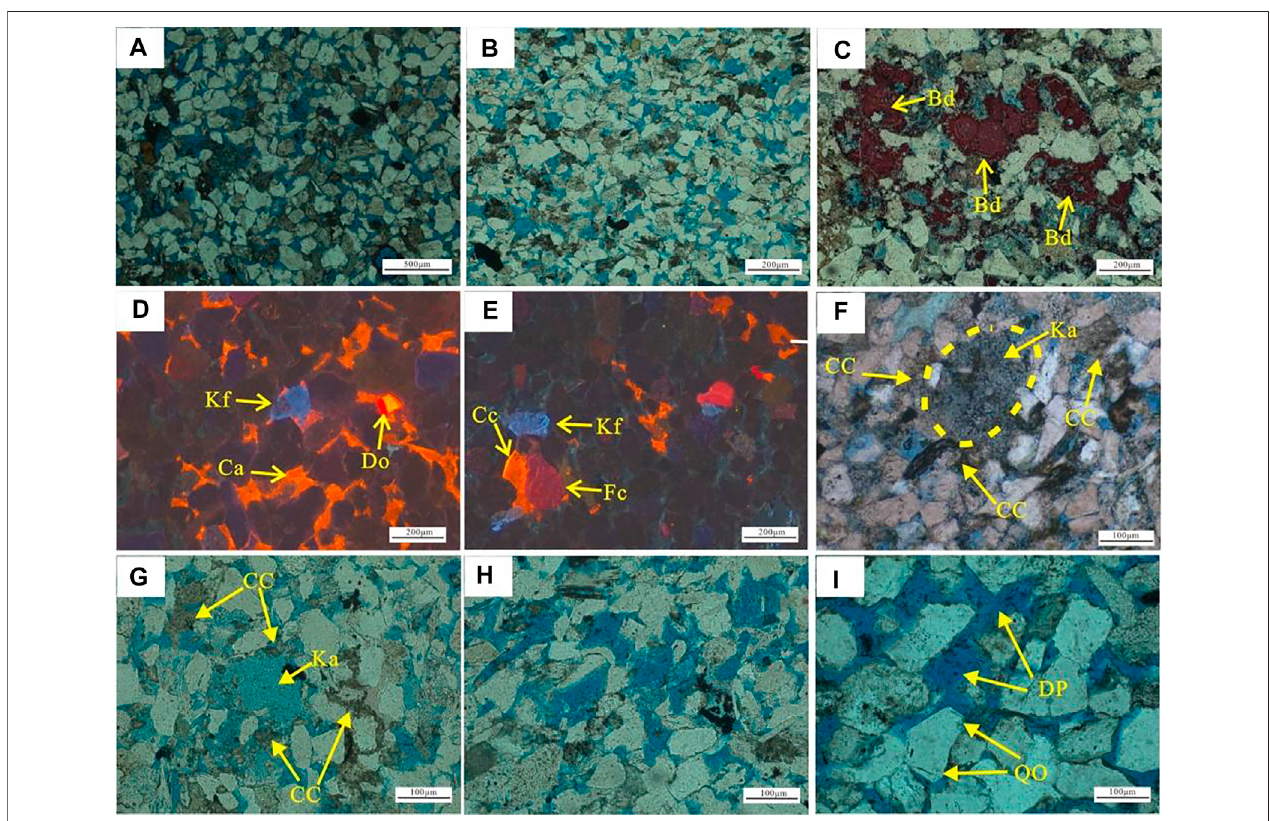
FIGURE 5 | Photomicrographs showing diagenetic characteristics of the Huangliu sandstones. (A) Well AF-2 – 1, 2,977.15 m, primary pores are well developed, and thetypes ofparticles contacts aredominatedbyline-pointand planar. (B) WellAF-1 – 2, 3,040.96 m,weak compaction and dissolutionpores aredistributedwidely. (C) Well AF-1 – 2, 2,992.16 m, biodetritus (Bd) are replaced by early carbonate cements. (D) Well AF-2 – 2, 3,134.16 m, calcite (Ca), dolomite (Do), and K-feldspar (Kf) fi ll intergranular pores. (E) Well AF-2 – 2, 3,067.64 m, the ferrocalcite (Fc) replace calcite (Ca) partly, and K-feldspar (Kf) are dissolved to some extent. (F) Well AF-1 – 2, 2,981.15 m, kaolinite (Ka) caused by feldspar dissolution exist in dissolved pores, and carbonate cements (CC) block pores and throats. (G) Well AF-1 – 2, 2,987.93 m, sandstones encounter strong dissolution, and related residual kaolinite and carbonate precipitation disperse in pore-throats. (H) Well AF-1 – 2, 3,047.09 m, feldspar grainsare strongly dissolved toform large pores and enlarge intergranularpores. (I) WellAF-2 – 4, 3,215.5 m, fewer residues are leftin dissolution pores (DP), and quartz overgrowth (QO) develops on detrital quartz.